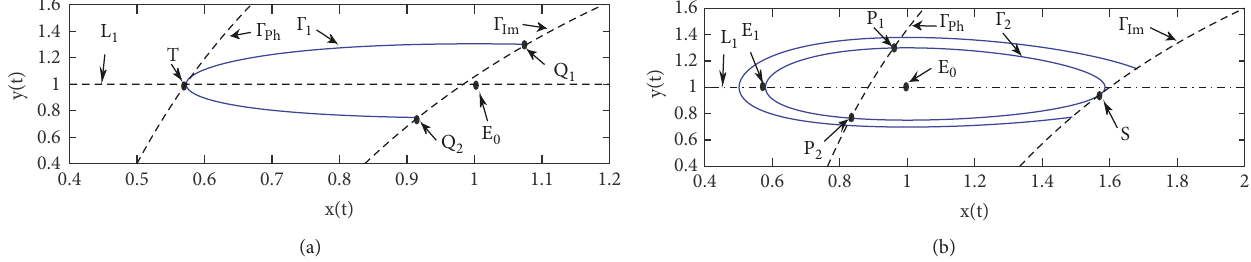
< 1 Γ 𝐼𝑚 at point